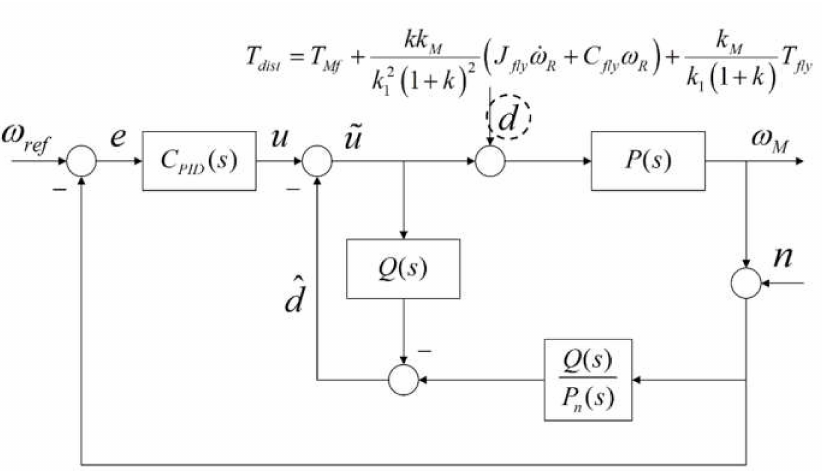
Figure 10. Disturbance observer for motor speed